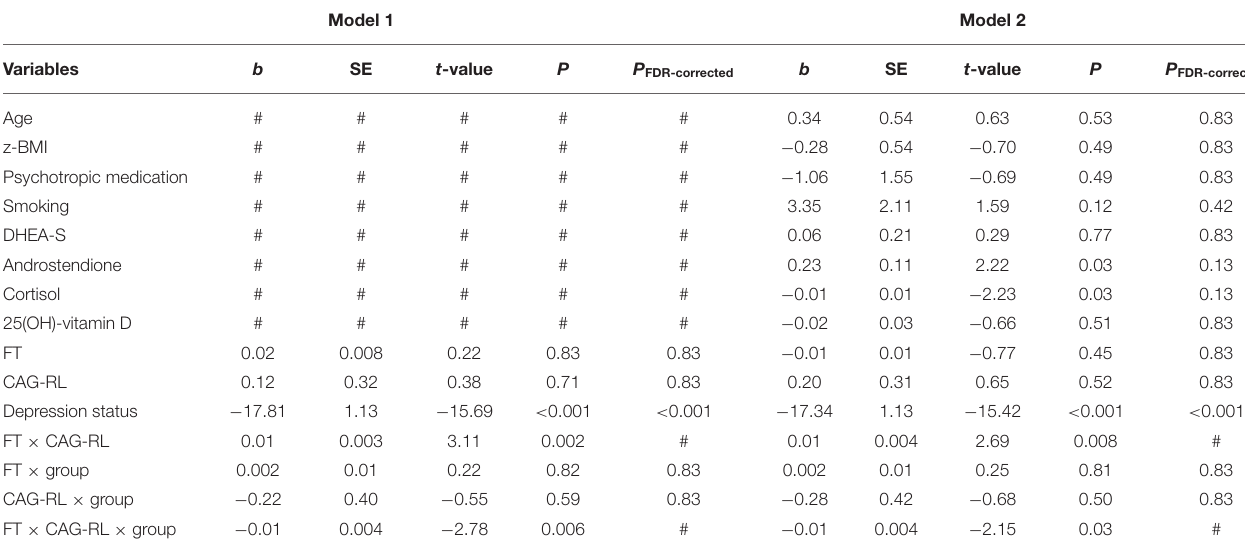
Table 4 | Results of the multiple regression